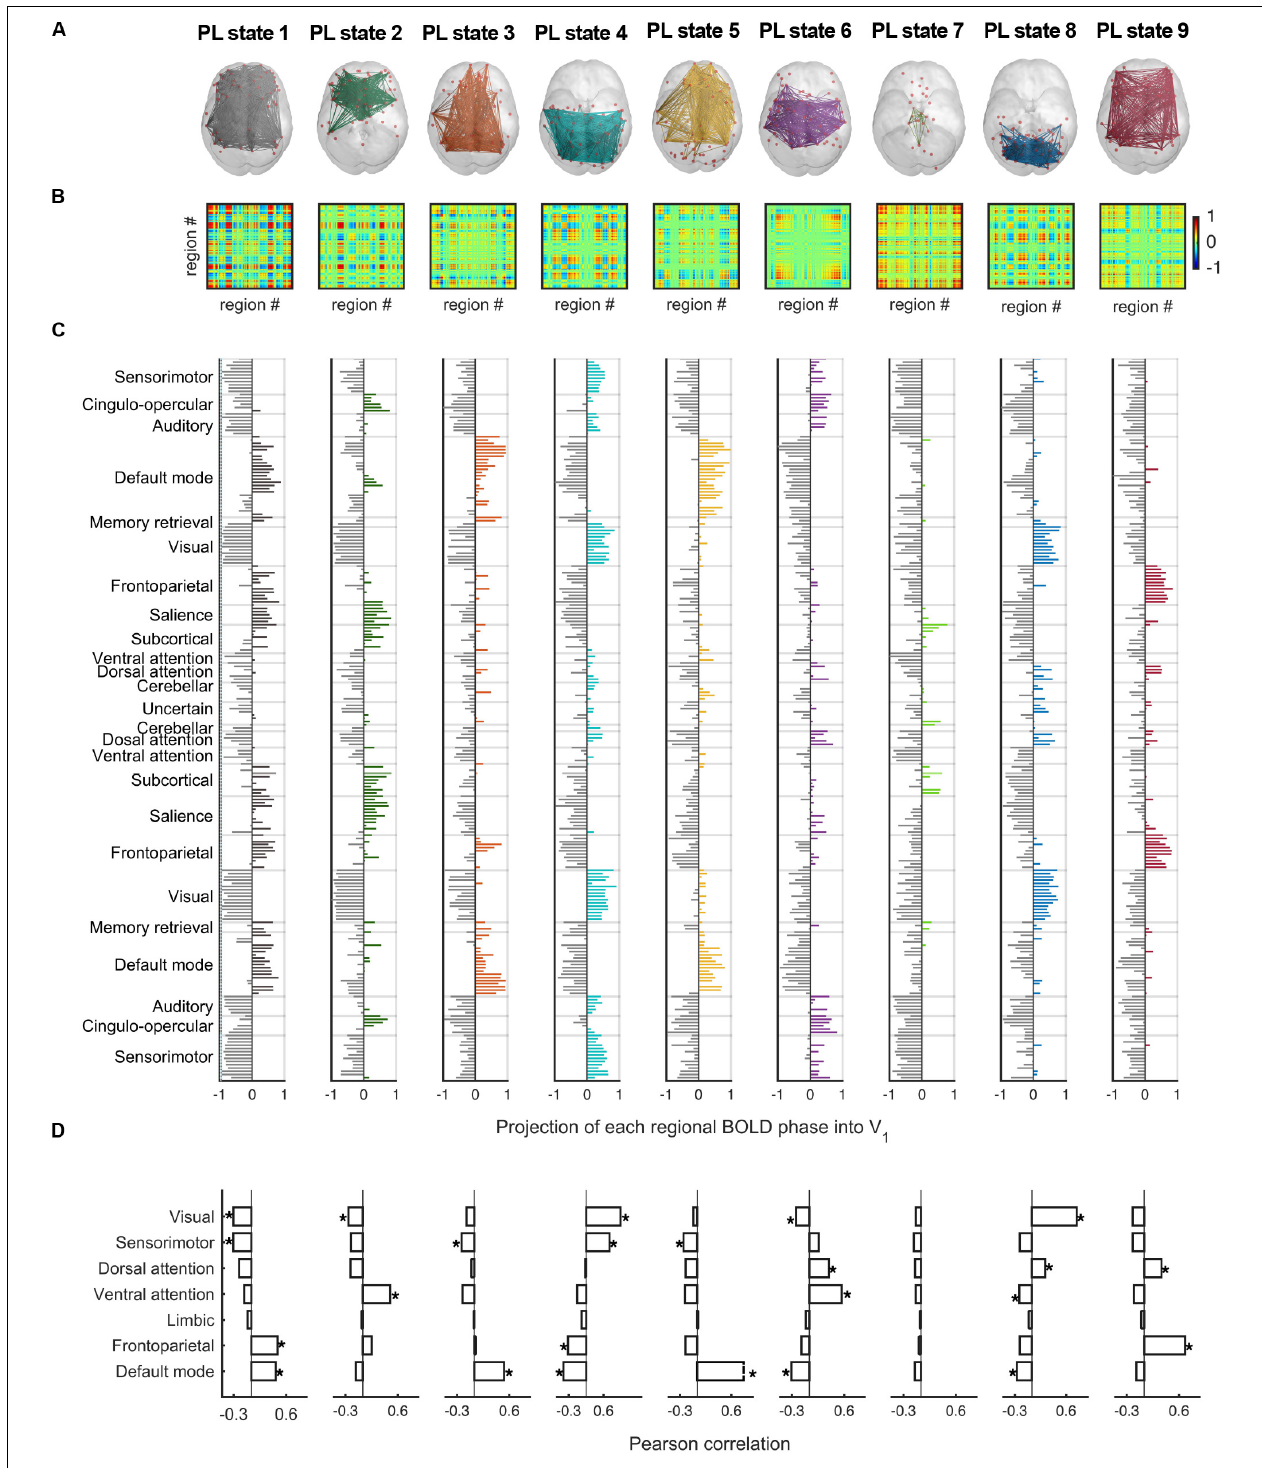
FIGURE 5 | The repertoire of 9 PL states detected by clustering the set of leading eigenvectors into 9 clusters. (A) Cortical space representation of each PL state. Only functionally connected brain regions are drawn (red spheres). Links between vector elements with Vc(n) > 0.3 are displayed to highlight the configuration captured by each centroid. (B) Matrices (223 × 223) obtained calculating the outer product of Vc, where positive (red) values indicate the product of Vc elements with the same sign, be they positive or negative. (C) Bar plot showing the N = 223 elements in Vc, representing the projection of the BOLD phase in each region into the leading eigenvector. (D) Pearson correlation of the 9 PL states returned by our partition model (LEiDA for k = 9) and the seven resting-state networks defined in Yeo et al. (2011). * p -value < 0.001. PL, phase-locking.